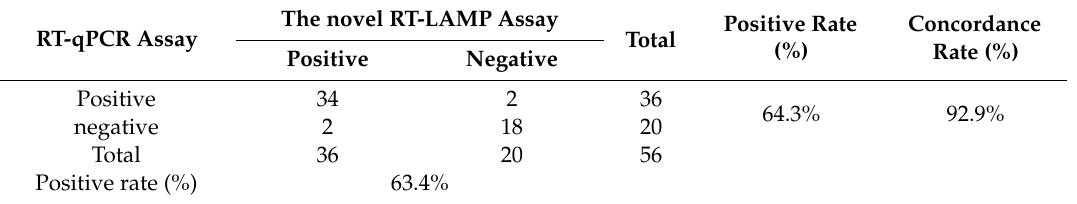
Table 3. Comparison of the novel RT-LAMP assay with a commercial RT-qPCR